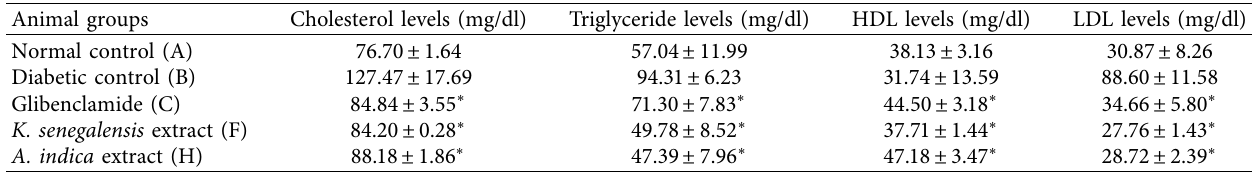
Table 2: Efect of oral administration of K. senegalensis stem bark and A. indica leaves hydroethanolic extracts on lipid profles of diabetic rats. Animal groups